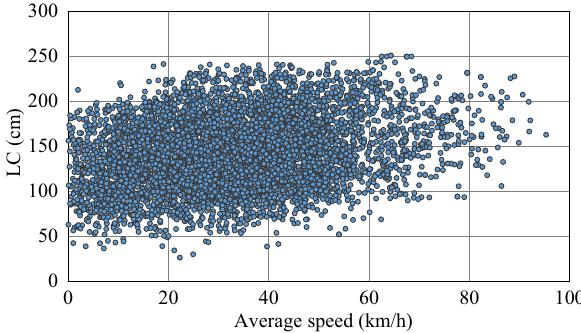
Fig. 4 Scatter plot of average speed ( v ) versus LC ( C ) between all interacting pairs of vehicles, combined data for all cities in this study